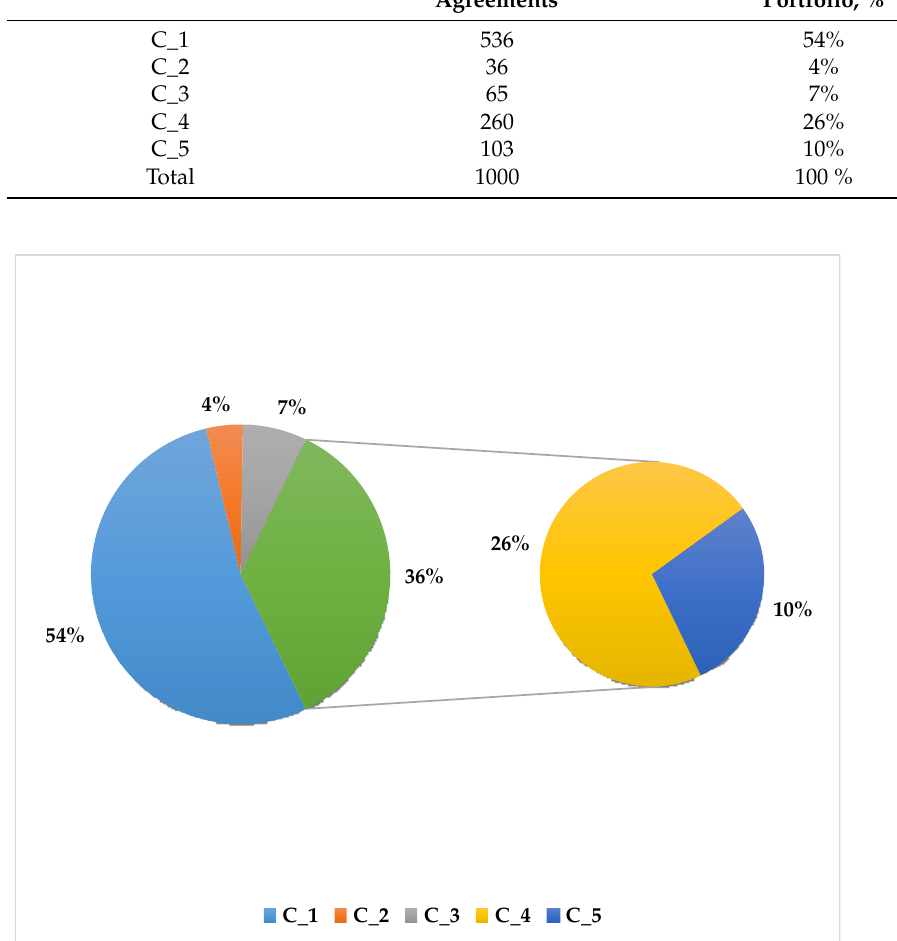
Table 6. Results of neuro-fuzzy segmentation of bank borrowers with active overdue payments. Debt Portfolio Segment